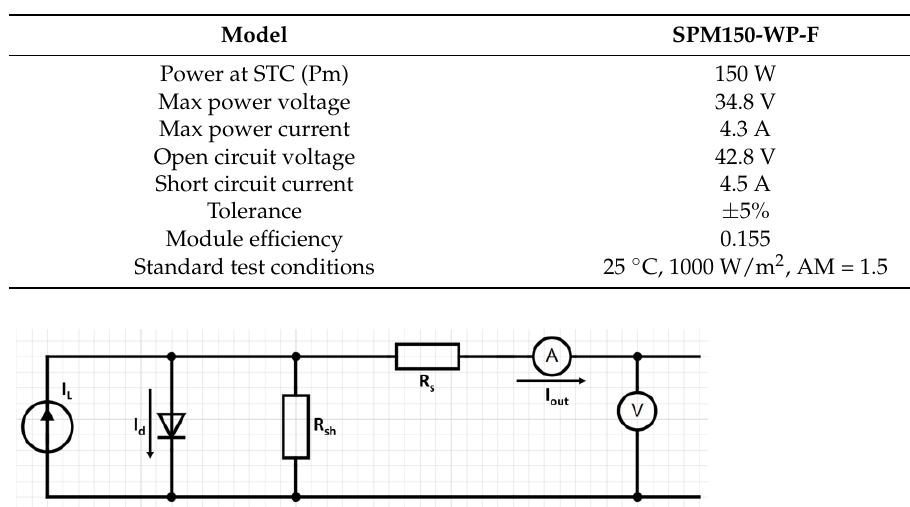
Figure 10. I-V curve simulation of the selected panel in different temperatures. Figure 11. Power curve simulation of the selected panel in different temperatures. Figure 12. I-V curve simulation of the selected panel in different irradiances.